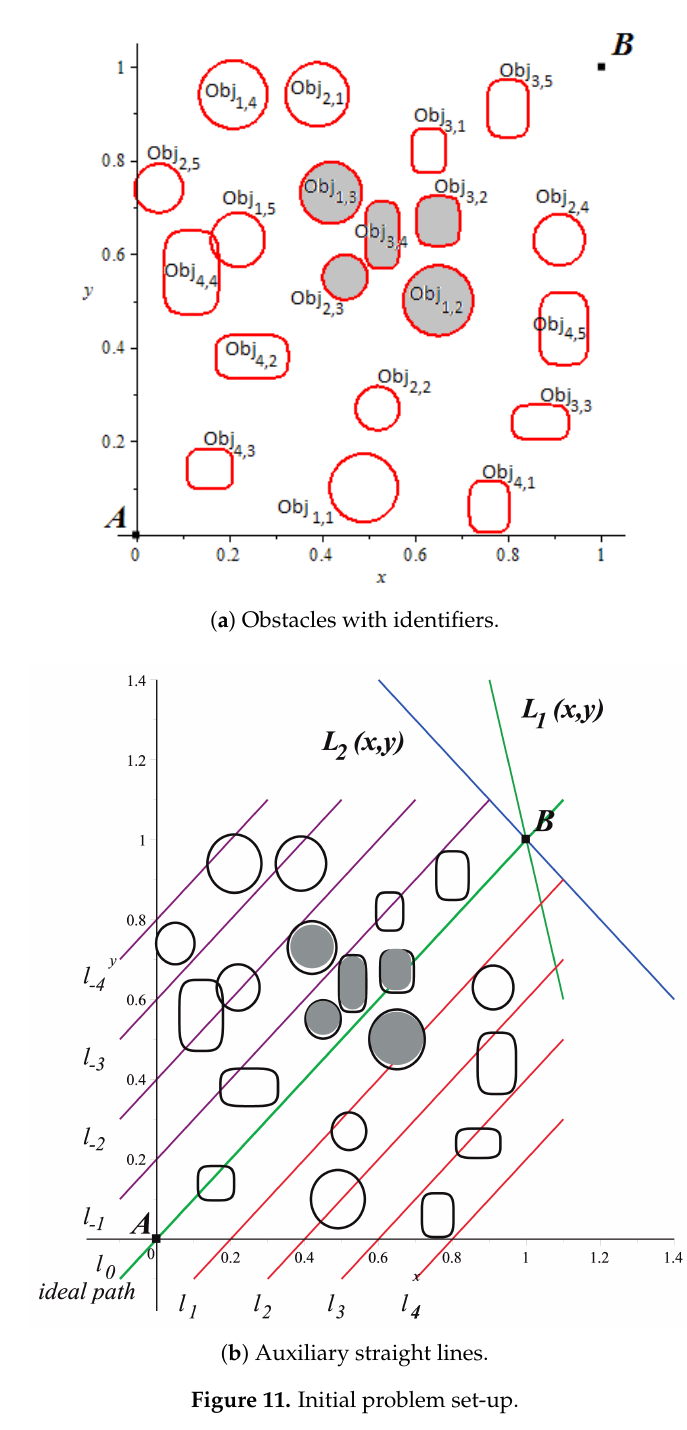
Figure 11. Initial problem